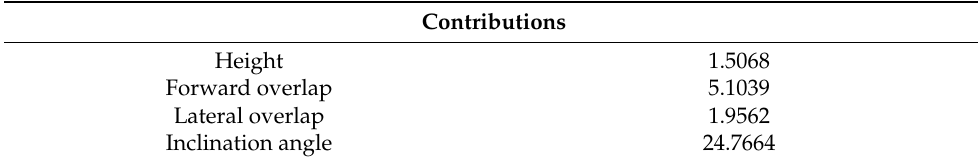
Table 10. Contribution of each